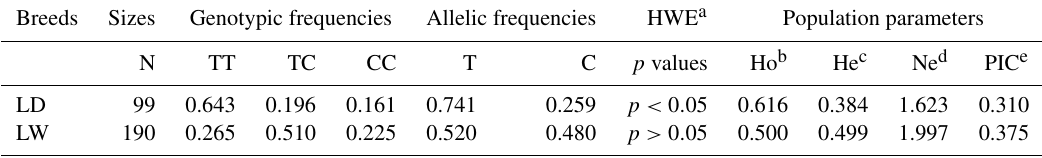
Table 2. Genotypic and allelic frequencies and population indexes for the A47A SNP of the pig TMEM95 gene. Breeds Sizes